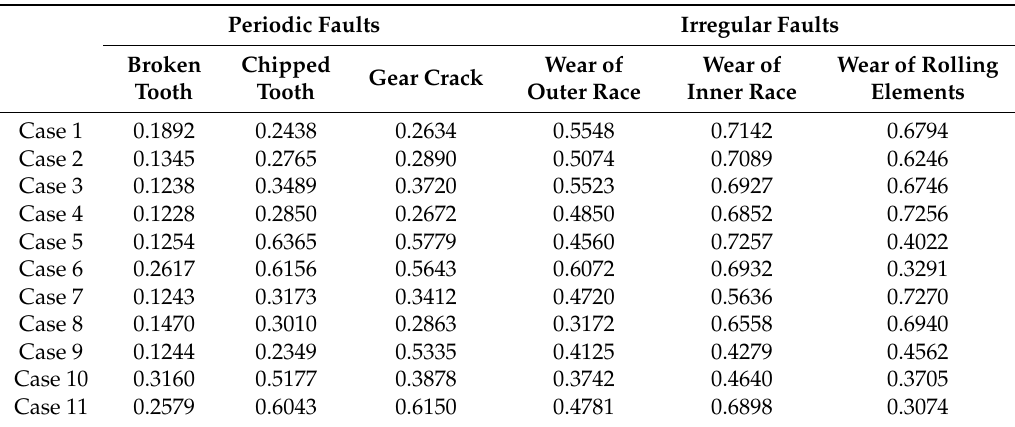
Figure 8. The experiment outcome based on singular value decomposition (SVD). Remark: Pattern recognition is based on the proposed method pairwise coupled extreme learning machine (PC-SBELM). Table 5. Results of 11 improperly classified cases using SVD.